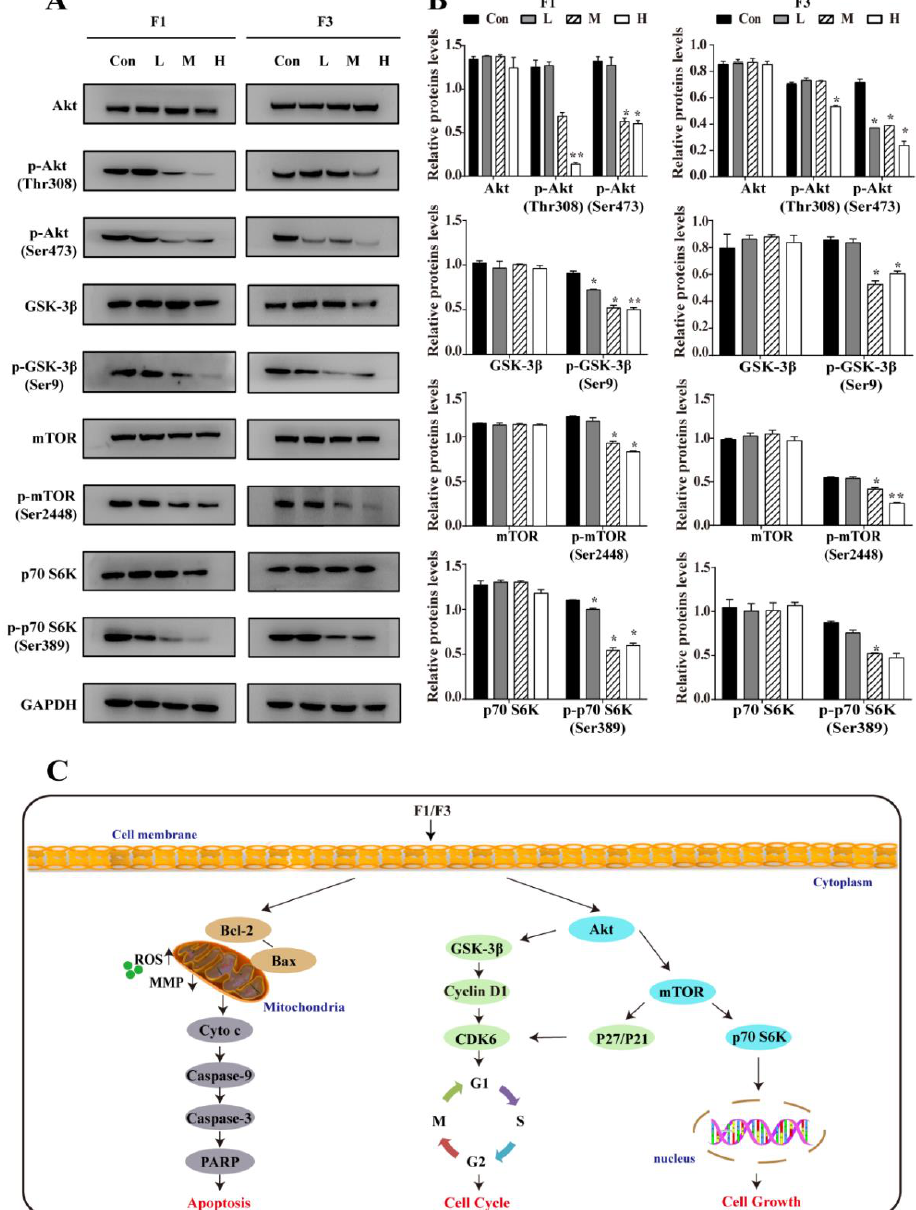
Figure 6. F1 and F3 suppressed the PI3K/Akt/mTOR signaling pathway in Jurkat cells. ( A ) The expression of Akt, p-Akt (Ser473), p-Akt (Thr308), GSK-3β, p-GSK-3β (Ser9), mTOR, p-mTOR (Ser2448), p70 S6K, p-p70 S6K (Ser389) in Jurkat cells treated by F1 or F3 were detected by Western blot. GAPDH was used as an internal control. ( B ) The histogram showed the relative protein levels in Jurkat cells treated by F1 or F3. Data were shown as mean ± SEM of three independent experiments; * p < 0.05 and ** p < 0.01 vs. the control group. ( C ) The possible mechanism of F1 and F3 effect in Jurkat cells. The pro-apoptotic effects of F1 or F3 were attributed to the activation of a mitochondria-dependent pathway mediated by ROS. On the other hand, the inhibition of the PI3K/Akt/mTOR signaling pathway could ultimately suppress cell growth and arrest cell cycle at G0/G1 phase. The uncropped Western Blot images can be found in Figure S3.